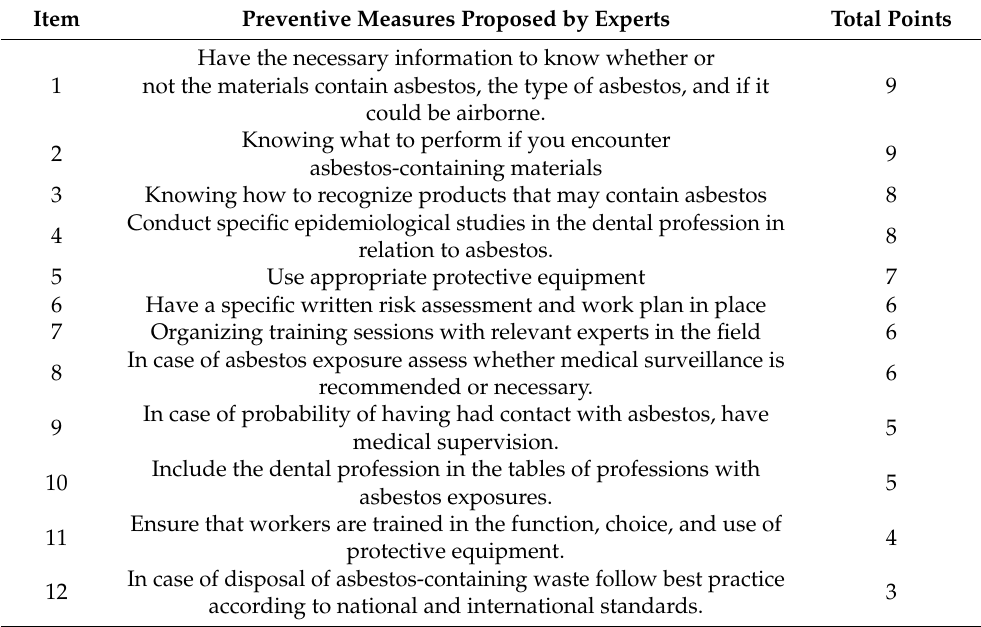
Table 1. Preventive measures proposed by the expert